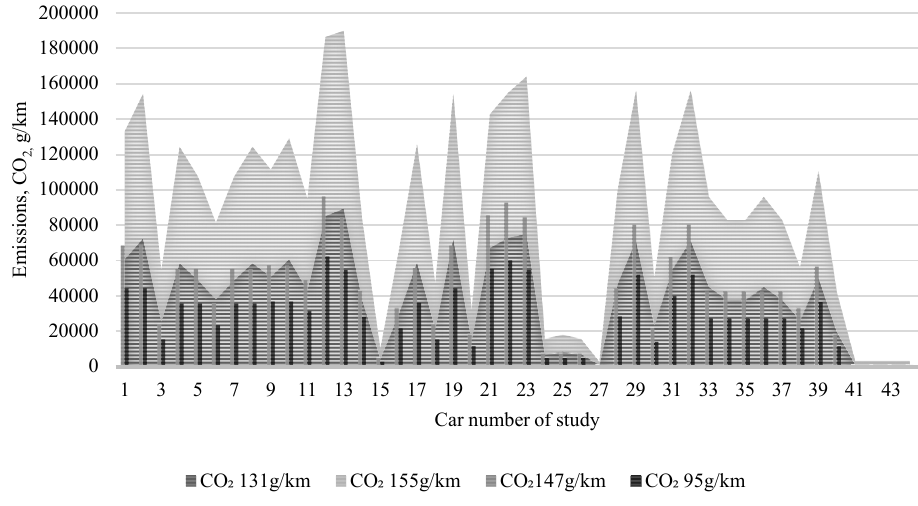
Fig. 7. Real CO 2 emissions of a journey for recreational fishing in comparison with hypothetical compliance with [37]. − Second